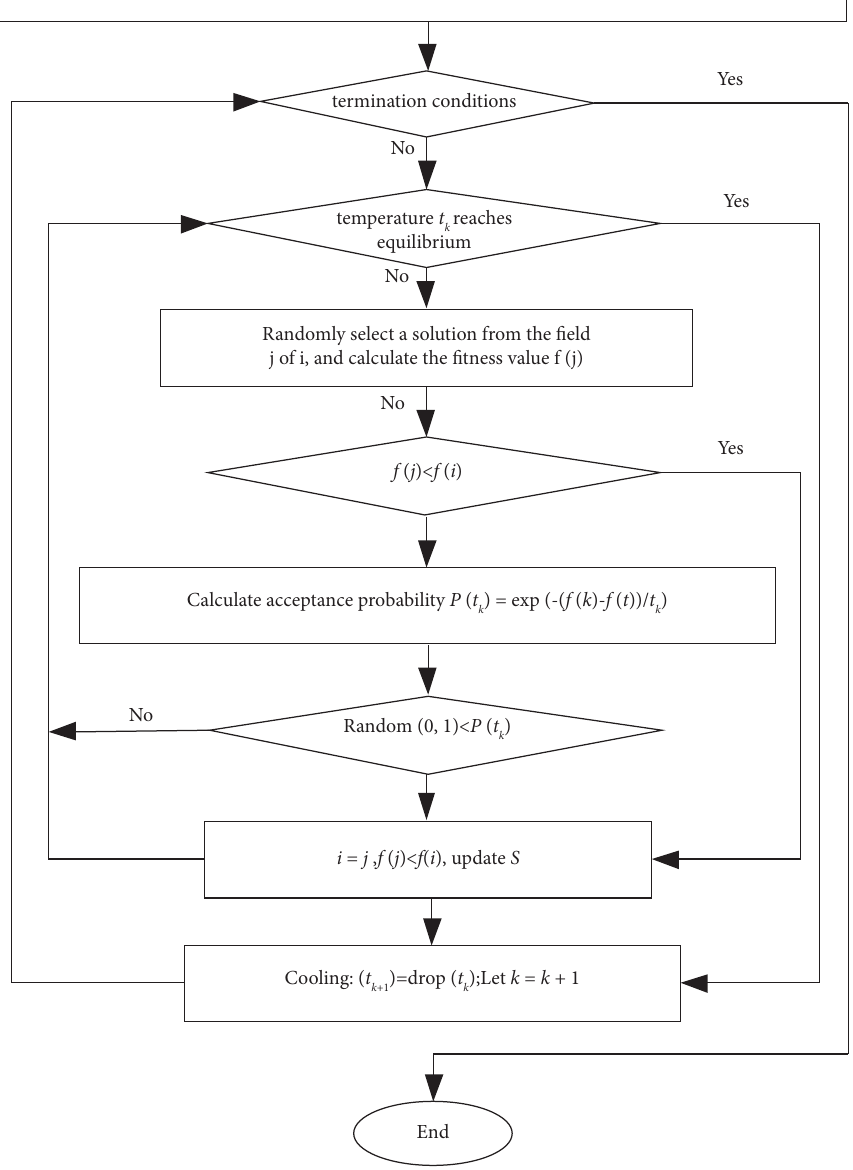
Figure 1: Flowchart of the simulated annealing